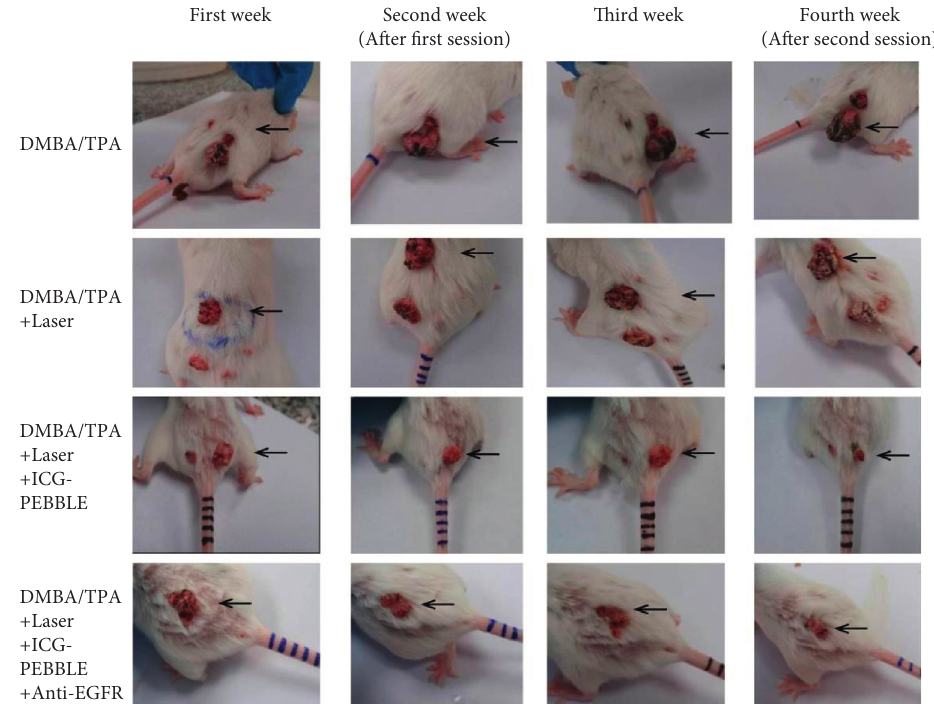
Figure 3: Photographs of tumor-bearing mice and tumor progression during PDT four-week experiments from various